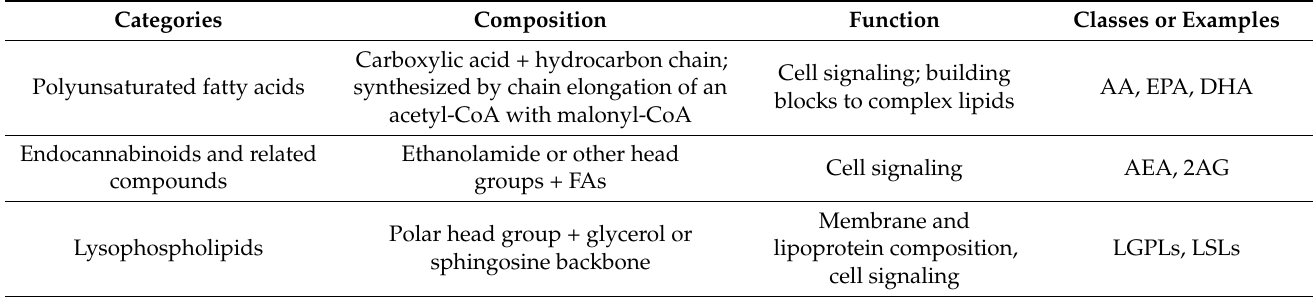
Table 1. Composition, functions, and classes or examples of the different categories of bioactive lipids.